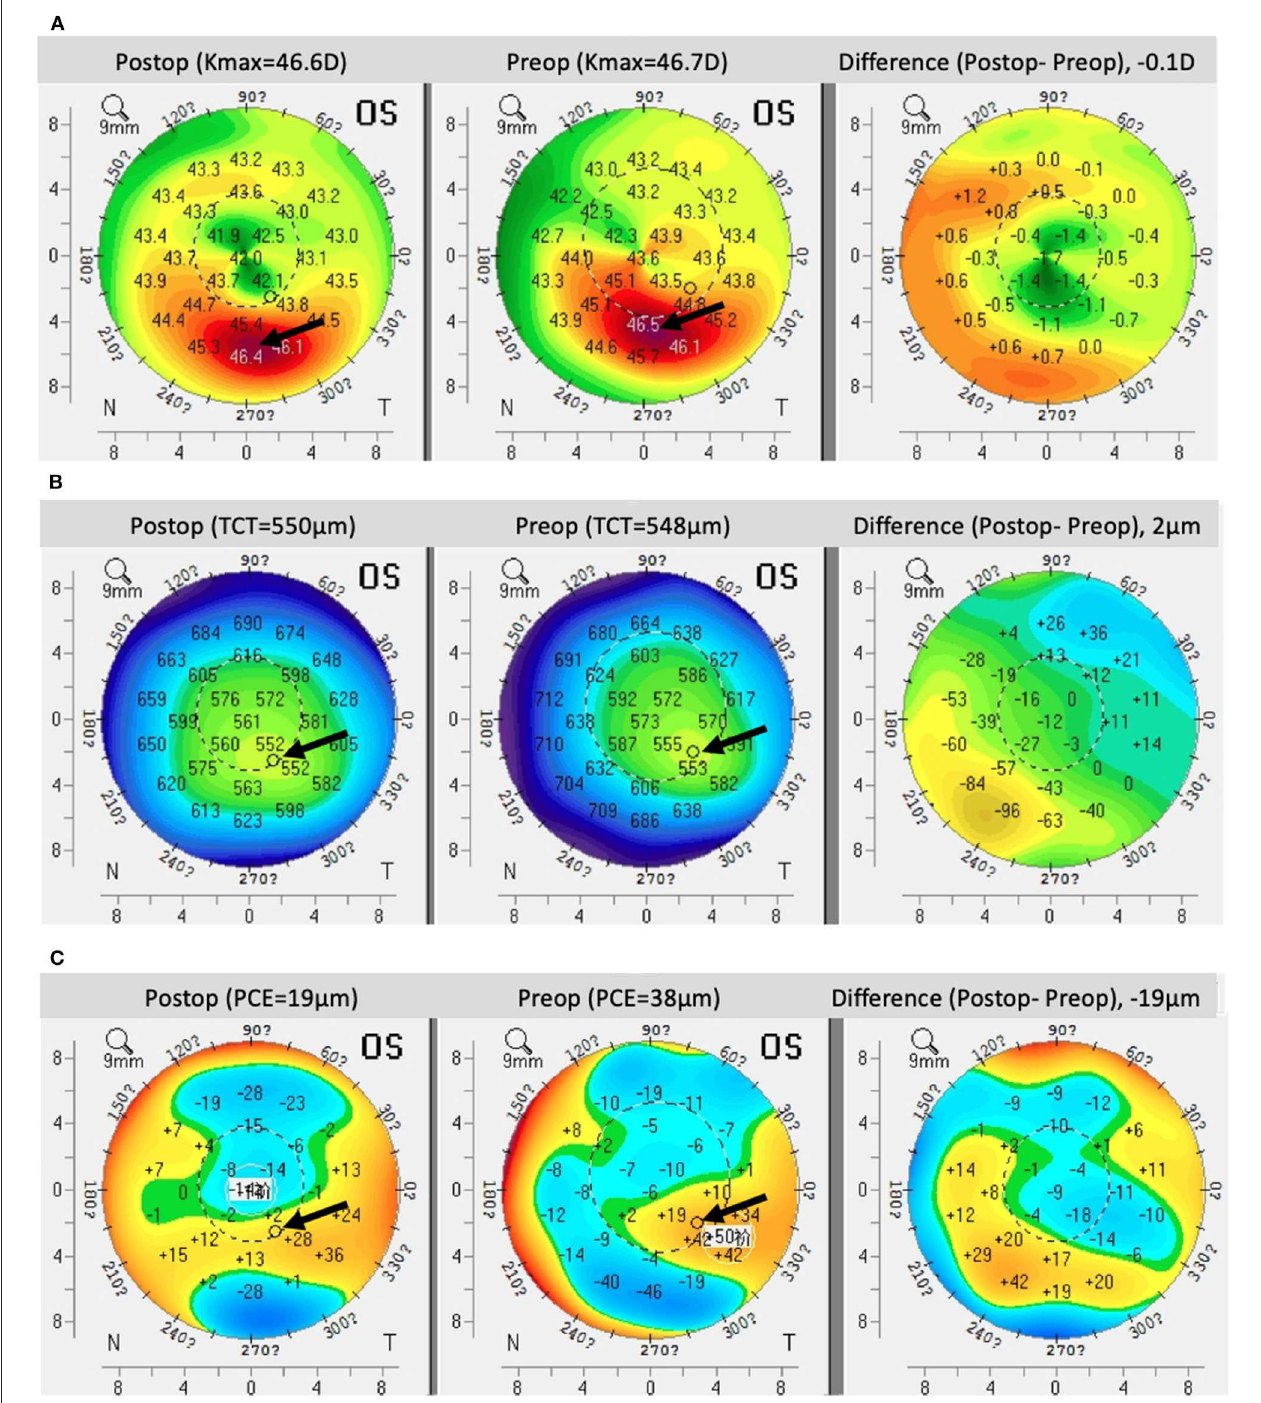
FIGURE 2 | Pentacam imaging comparing (A) front curvature, (B) corneal thickness, and (C) posterior corneal elevation prior to treatment and 4 years after ATE-CXL treatment. Black arrows indicate the designated areas.